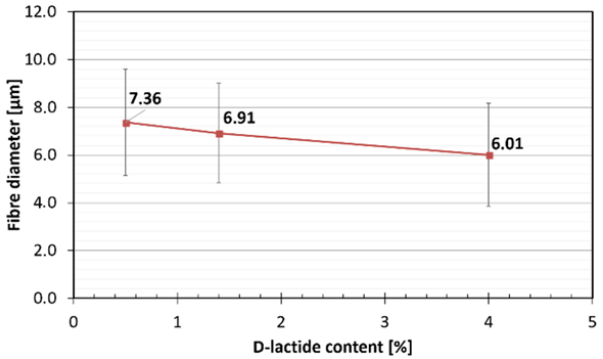
Figure 2. Diameters of the melt ‐ blown PLA fibres.